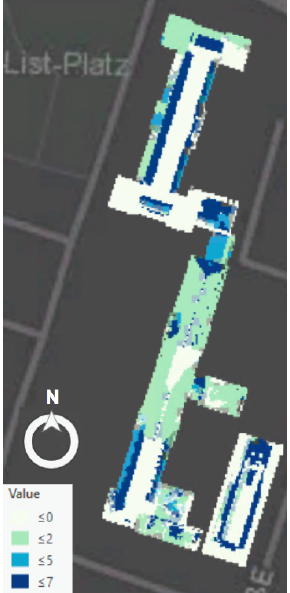
Figure 4. Shadow frequency (value in legend) throughout the roof of the three buildings on winter